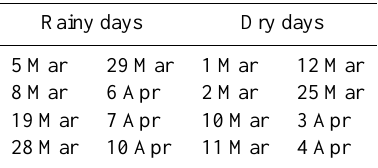
Table 3. Rainy and dry days during March and April,